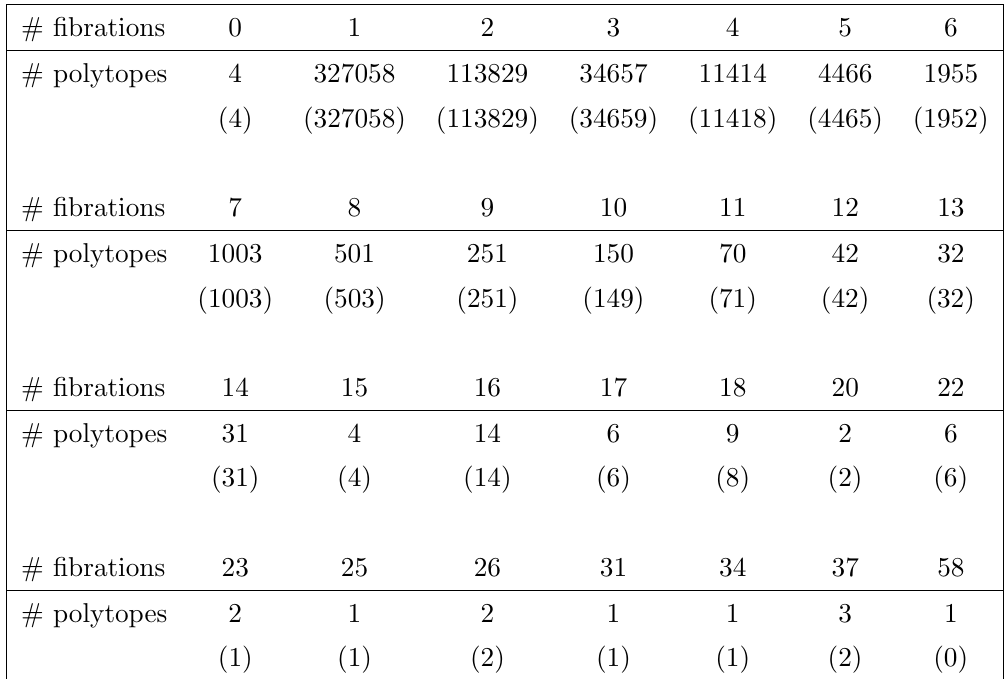
Table 3 . Table of the number of polytopes in the large Hodge number regions h 1 ; 1 ; h 2 ; 1 (cid:21) 140 that have a given number of distinct (manifest) (cid:12)brations. Numbers in parentheses are after modding out by automorphism symmetries (see text, appendix